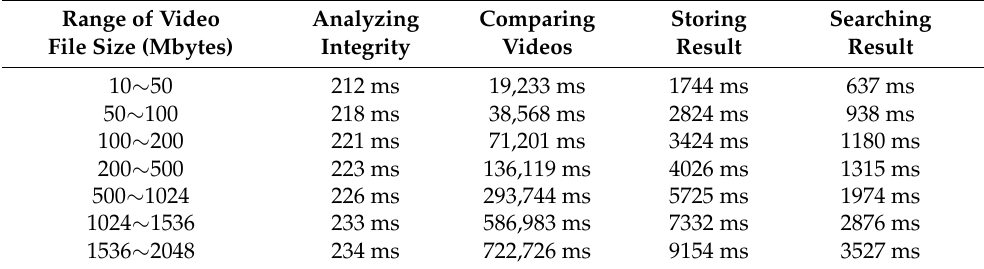
Table 3. Execution time against video size on the blockchain